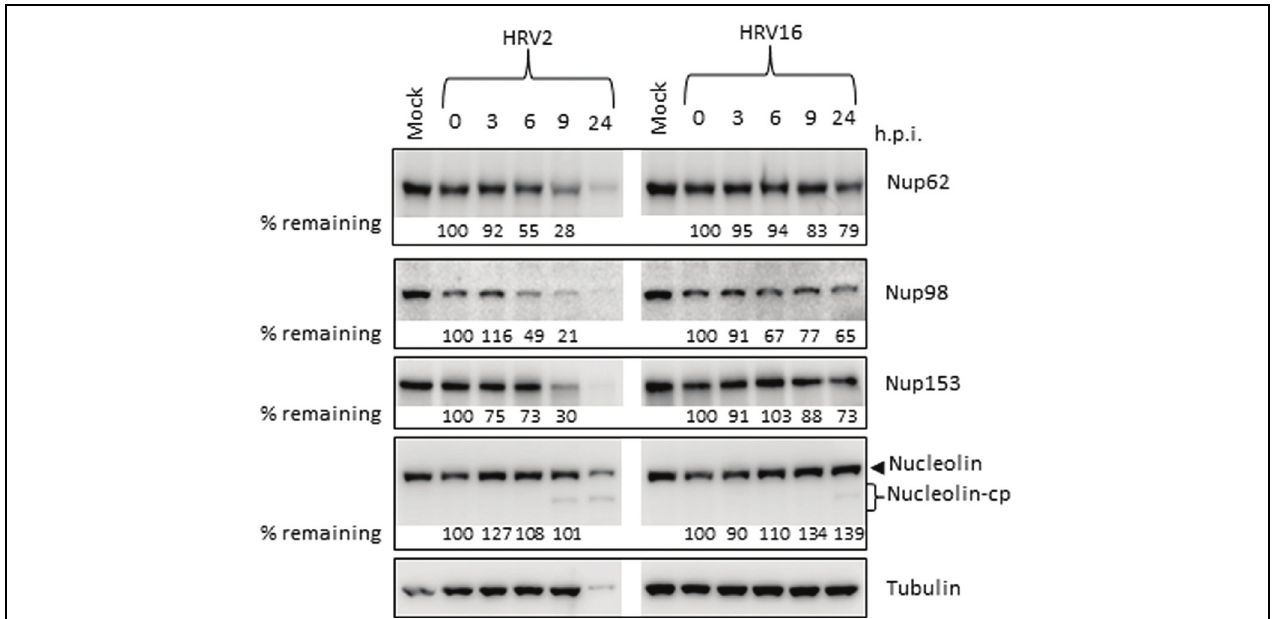
FIGURE 2 | Human rhinovirus protease activity occurs at different times after infection with HRV2 or HRV16. Cell lysates were prepared and subjected to Western analysis as for Figure 1 . The specificity of the antibodies is indicated on the right. Where cleavage products are observed, bands corresponding to full length proteins are indicated with arrowheads and